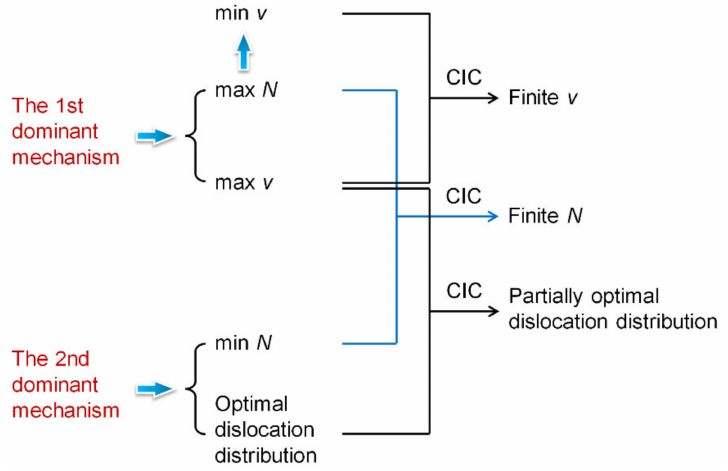
Figure 3. Compromise in competition between the two dominant